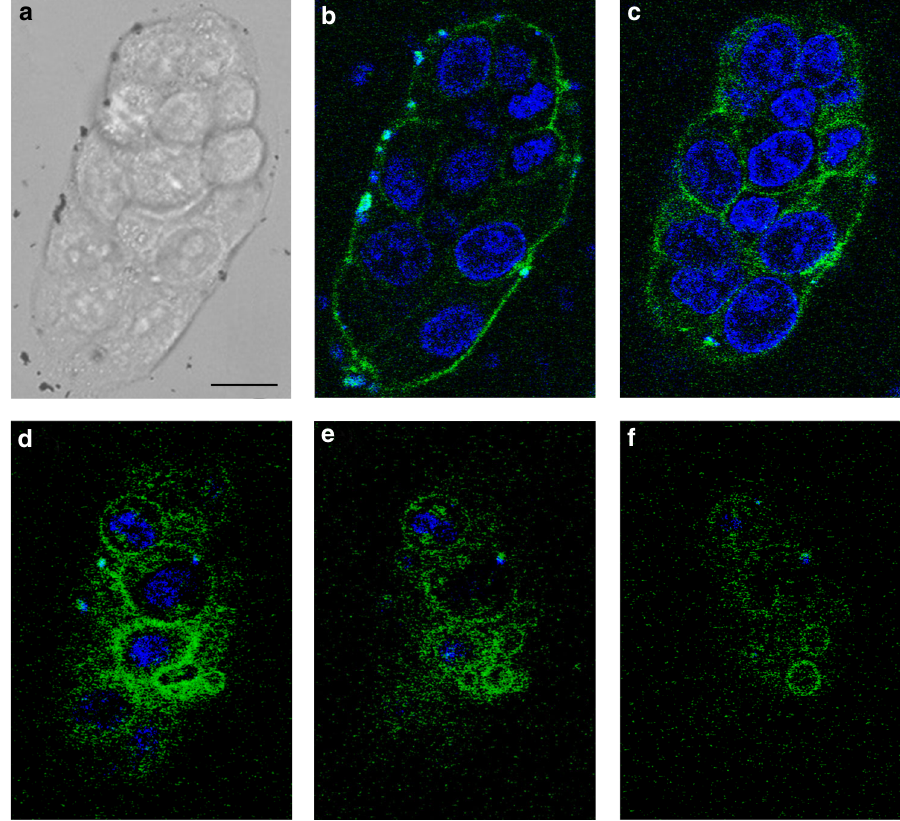
Fig. 2 Gold nanoparticles distribution on the cell outer membrane surface detected by CFM. The analysis was performed on the cluster of MKN28 cells shown in a and treated with the AuNP of Fig. 1b according to our protocol. In b – f are reported the fl uorescence images collected at z = 0, 6, 12, 14, and 16 µ m, respectively. Green is the Alexa488 dye linked to the AuNP, while the nuclei were stained with blue Hoechst 33342 dye. In some locations of the glass bottom dish, close to the cell cluster at z = 0, we noticed microscopic AuNP aggregations, in which traces of Hoechst dye were detected. In Supplementary Movie 1, we combined the collected images to create a movie of the z -stack sections through the cells. Scale bar: 10 µ m